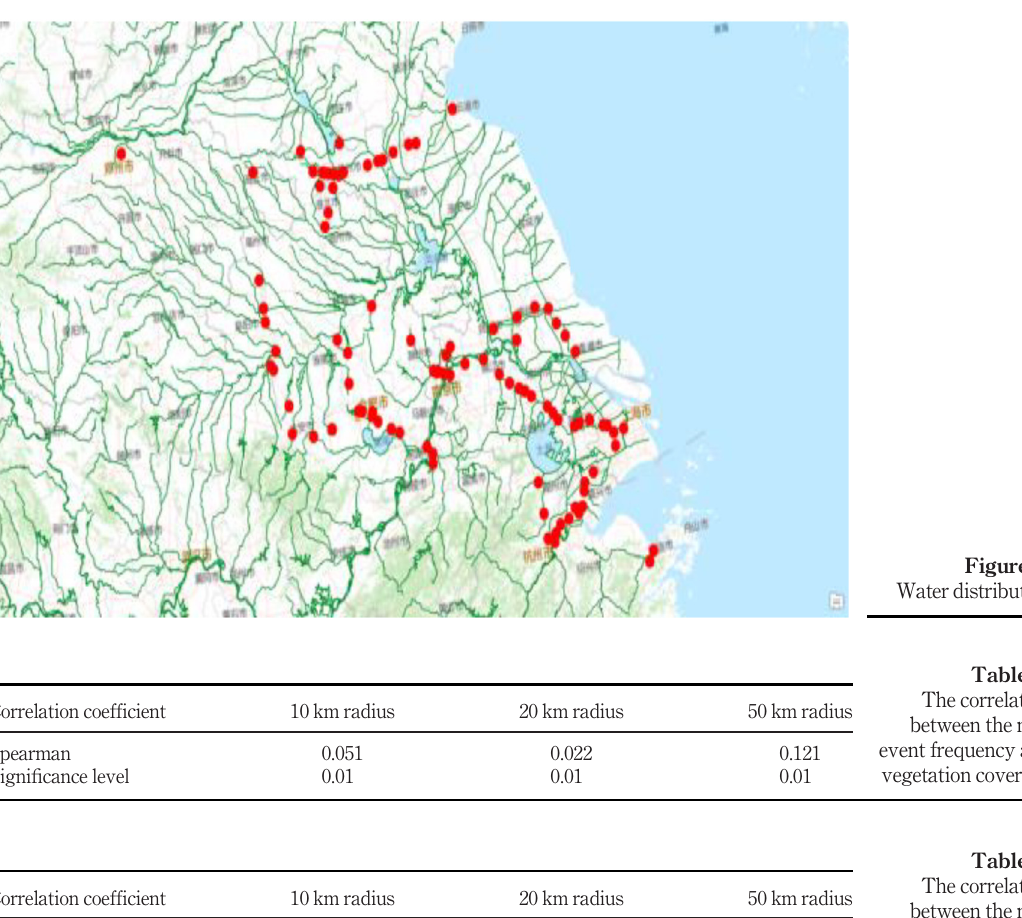
Figure 6. Water distribution